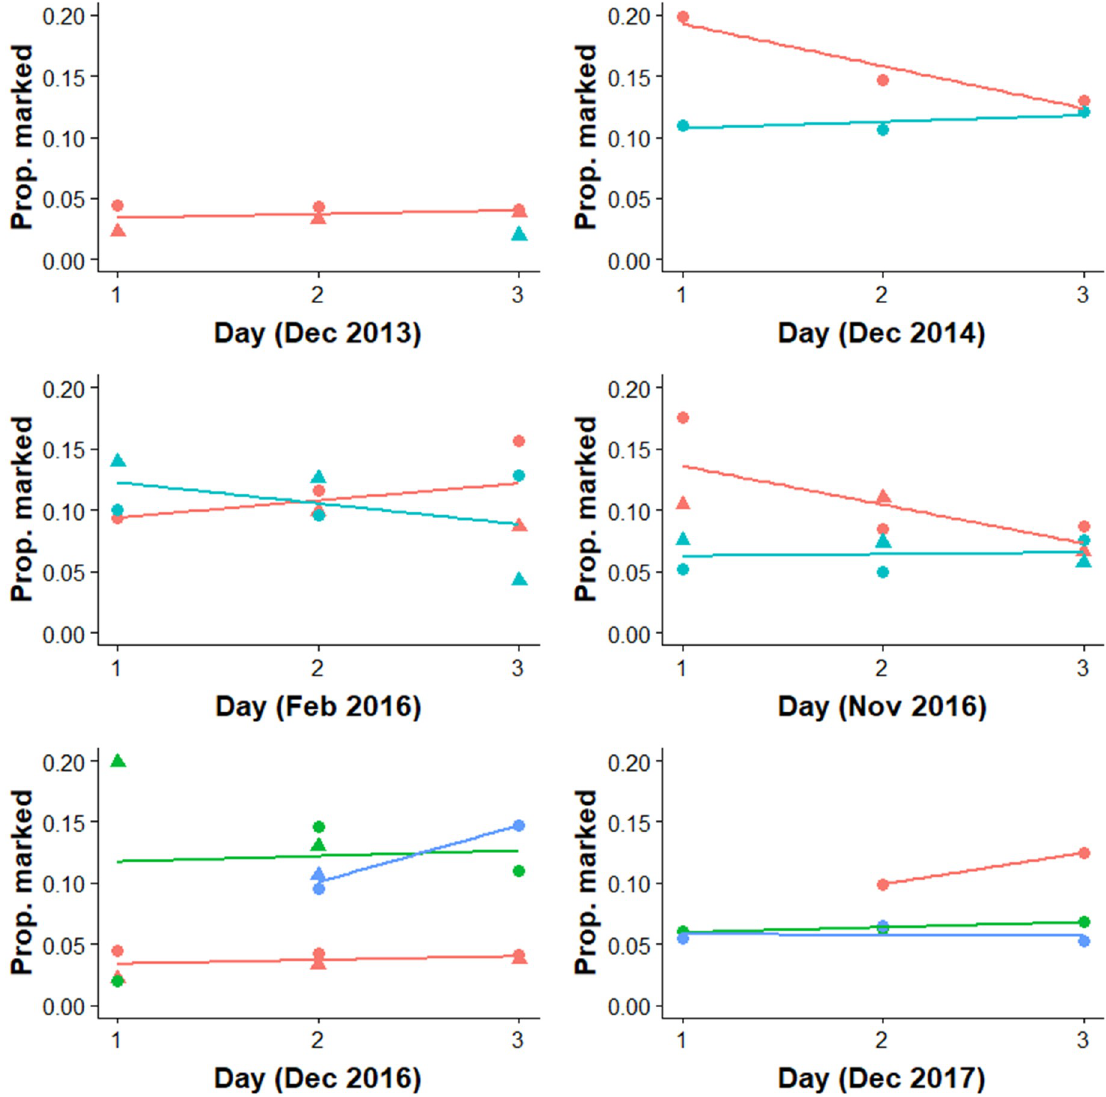
Fig 4. Proportion of marked turtles detected for each method. Coloured points represent the method (Red: surface observer; blue, underwater video; green, UAV) and shapes represent the diel period (circles: morning; triangles: afternoon). Samples were collected over three successive days on each occasion. The coloured lines represent the average trend over time for each method and period. Once variation associated with survey period was accounted for, there was no significant difference in detectability between the UAV and underwater video methods (Fig